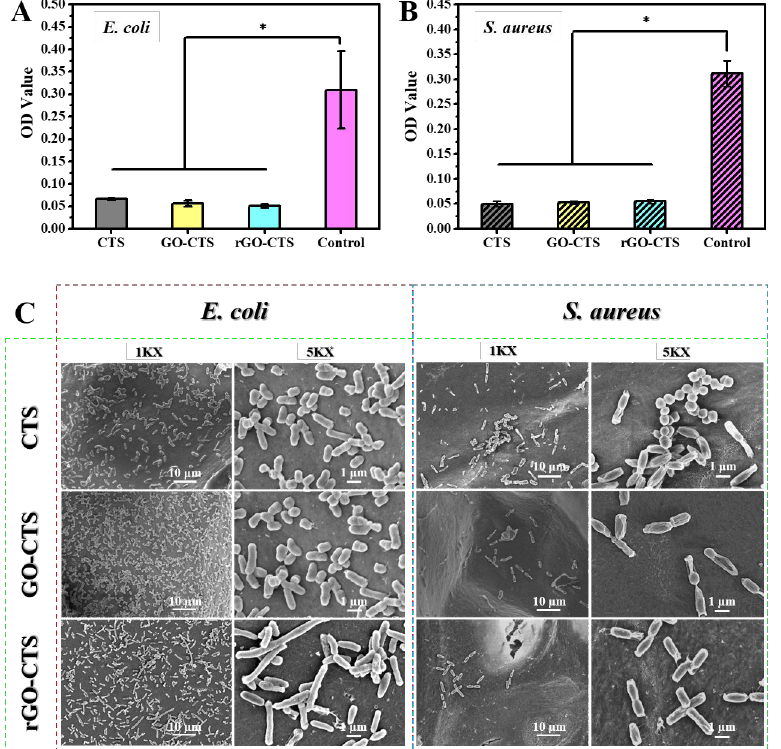
Figure 5. Antibacterial activity of the CTS, GO-CTS, and rGO-CTS cryogels. OD values of E. coli ( A ) and S. aureus ( B ) on the CTS, GO-CTS, and rGO-CTS cryogels, respectively; ( C ) SEM images of E. coli and S. aureus on the CTS, GO-CTS, and rGO-CTS cryogels, respectively. The SEM of E. coli was represented by red dotted areas, the SEM of S. aureus was represented by blue dotted areas, and the SEM of three cryogels was represented by green dotted areas. * p < 0.05